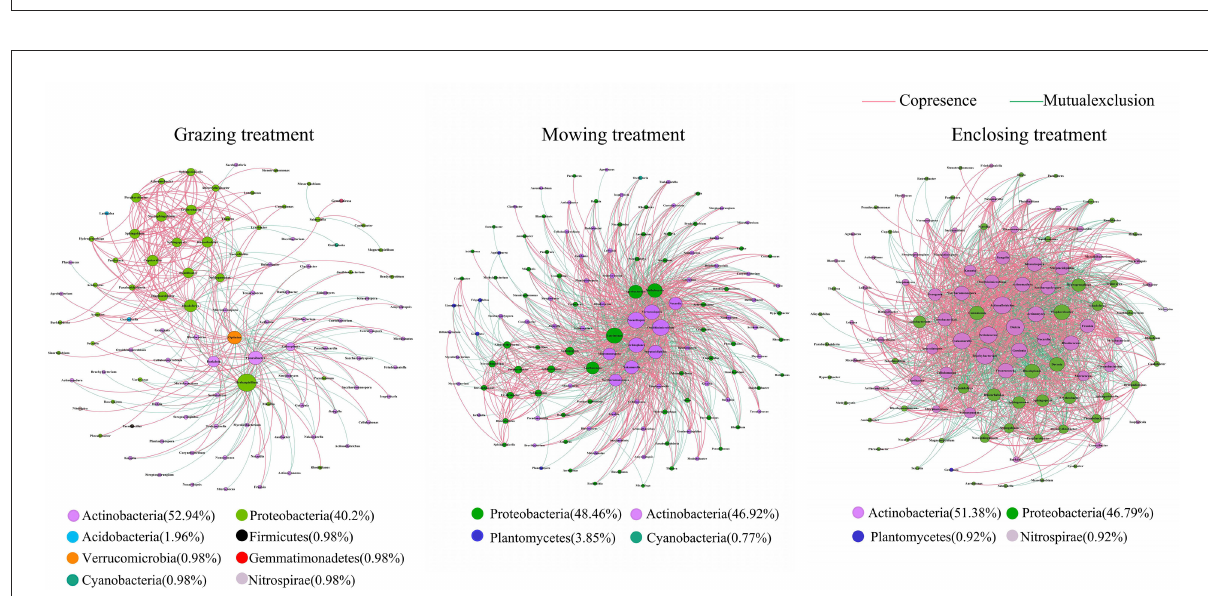
FIGURE8 Relationship network of rhizosphere soil microbial communities under different utilization patterns. The explanation of the figure is the same as that of Figure 7.